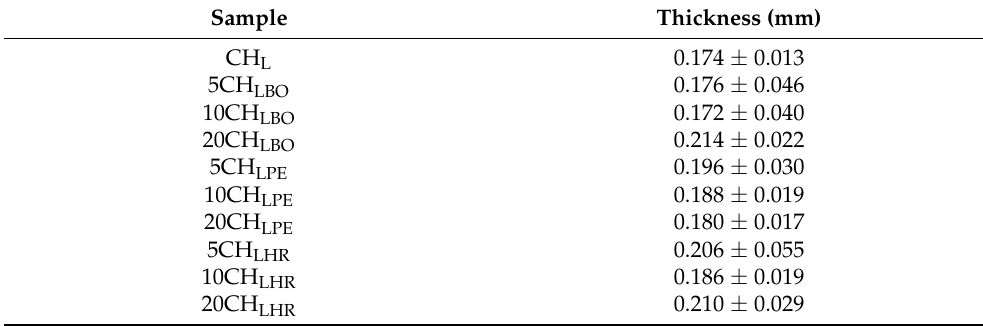
Table 3. Thickness of chitosan